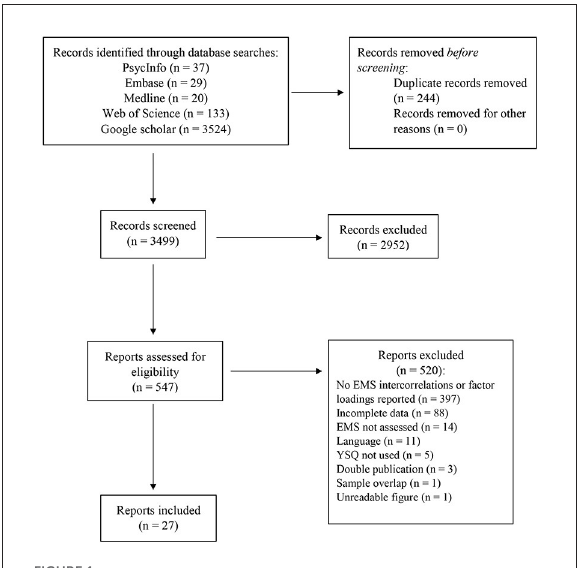
FIGURE1 Flowchart of the search and selection